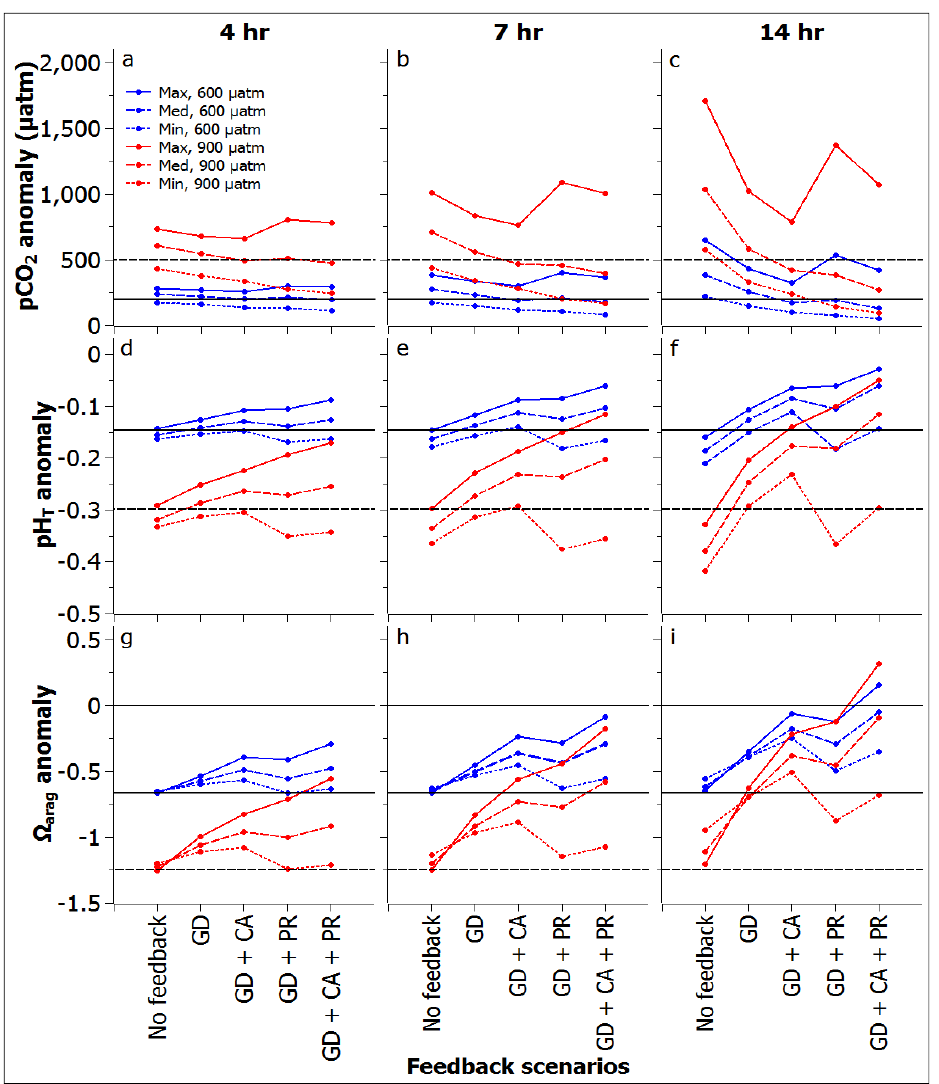
Figure 3. Plots showing seawater chemistry anomalies relative to present-day conditions on the reef flat under each model scenario. Data are hourly average maximum, median, and minimum. Thick, black lines in each plot show the magnitude of the anomaly relative to offshore, seawater chemistry conditions ( i.e. , the “expected” anomaly): solid black line = 600 µatm; dashed black line = 900